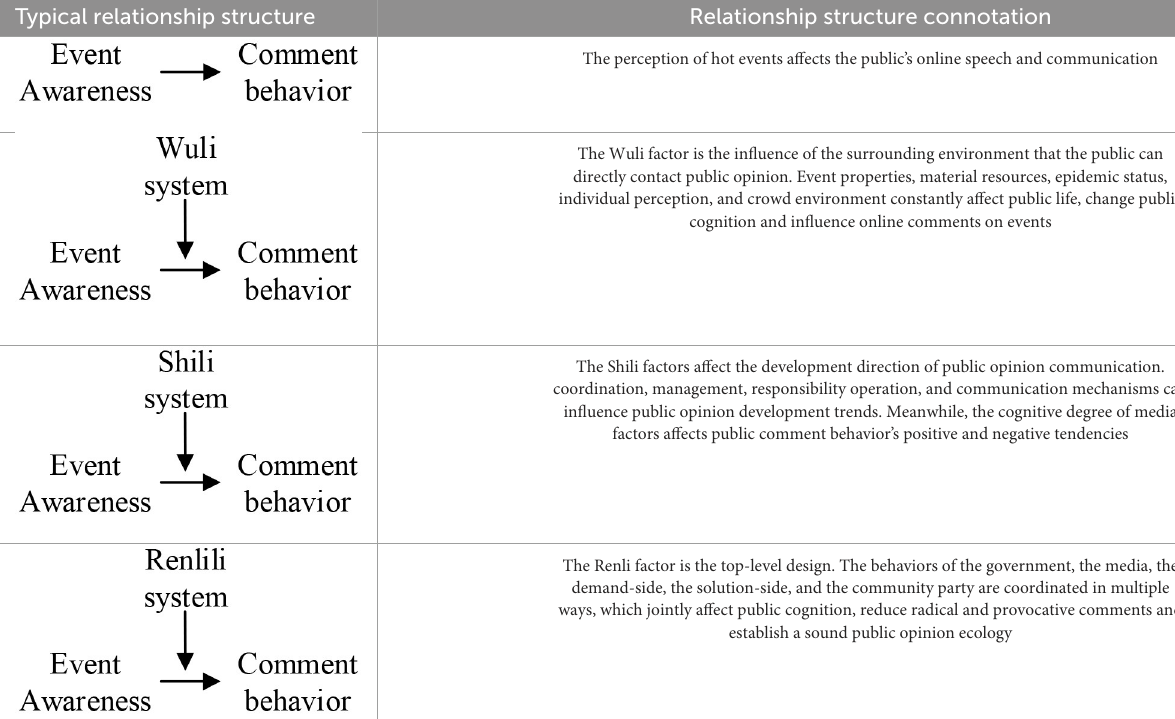
TABLE 3 Typical relationship structure. Typical relationship structure Relationship structure